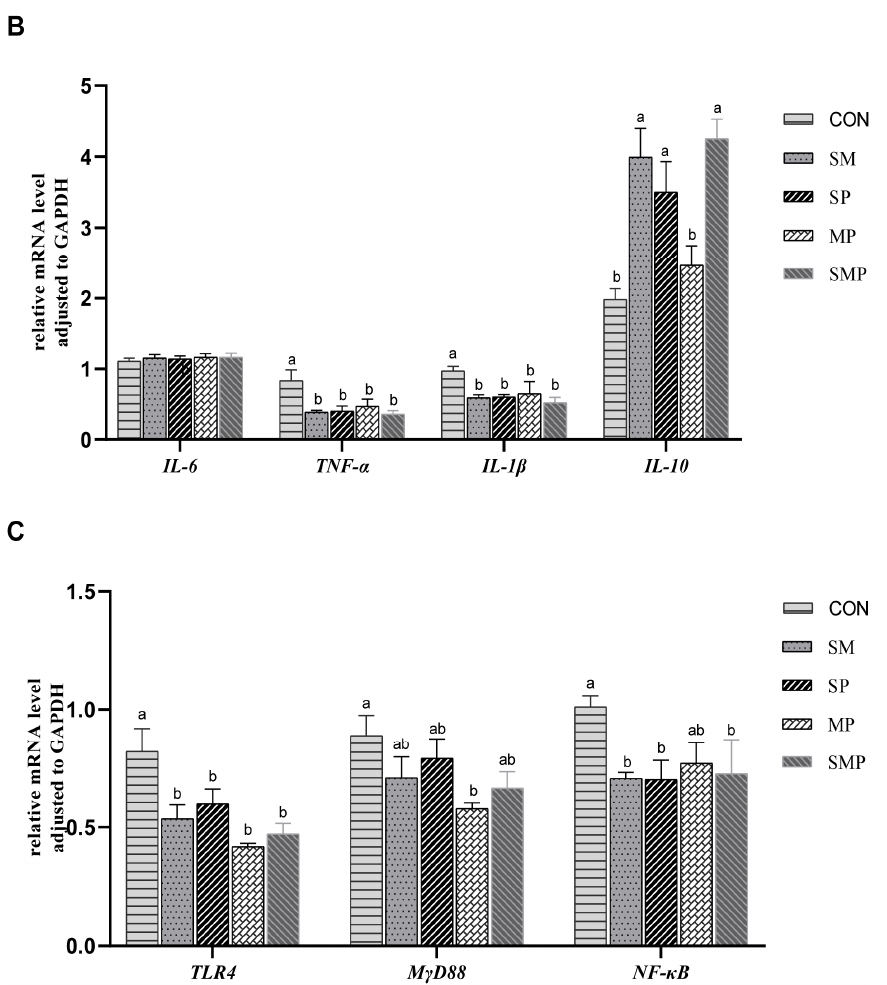
Figure 2. Effects of supplementing the diets with different combinations of SB, MCFAs, and omega − 3 PUFA on the tight junction proteins and inflammatory cytokines in the jejunal mucosa of suckling piglets. The relative expression of Claudin-1 , ZO-1 , Occludin , IL-1 β , IL-6 , IL-10 , TNF- α , TLR-4 , M γ D88 , and NF- κ B mRNA in the jejunal mucosa ( A – C ) were determined via real-time PCR. Data are expressed as the means ± SEM ( n = 6). a–c Values within a row with different superscripts differ significantly at p < 0.05.